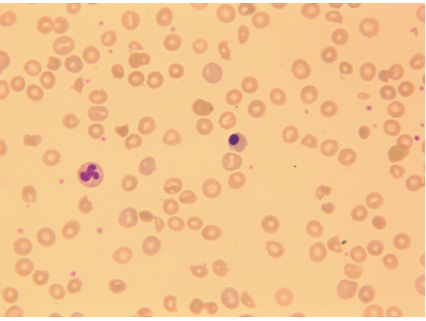
Figure 1: Polychromasia, nucleated red blood cells, and fragments on presentation.